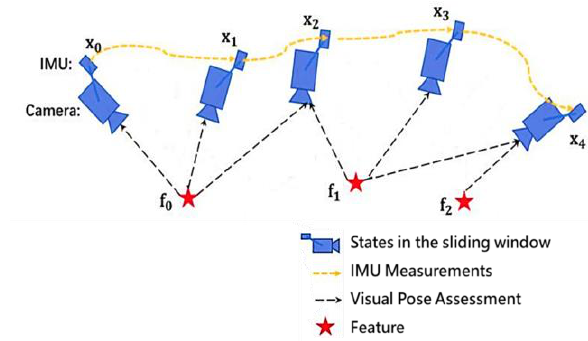
Figure 3. Illustration of the sliding window monocular VINS